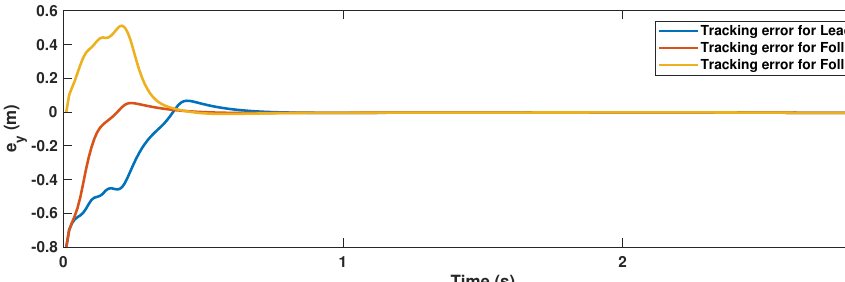
Figure 15. Path 3: The tracking error on the Y-axis.